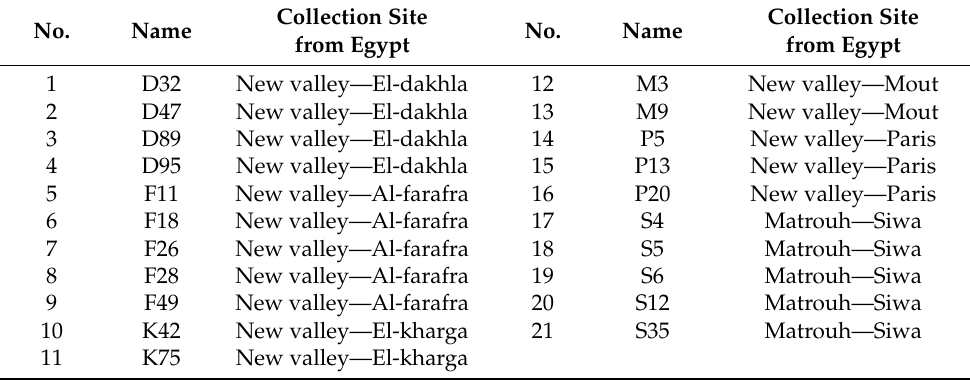
Table 2. Soil mechanical analysis at EL- Ismailia agricultural station.